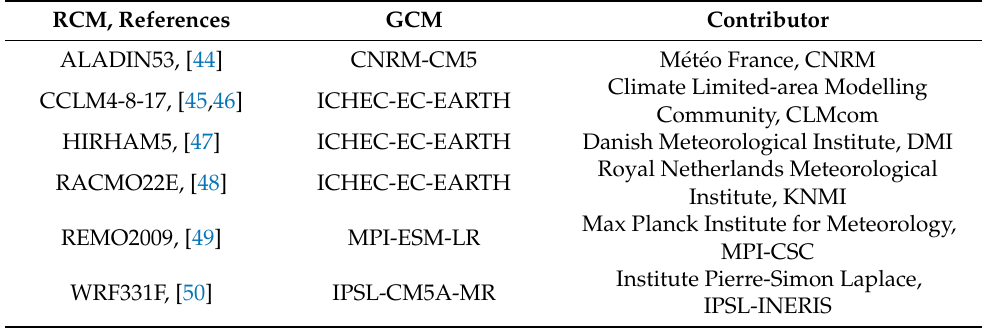
Table 1. Acronyms of the selected regional climate models (RCM) and their corresponding driving global climate models (GCM), along with the contributor institutions for the